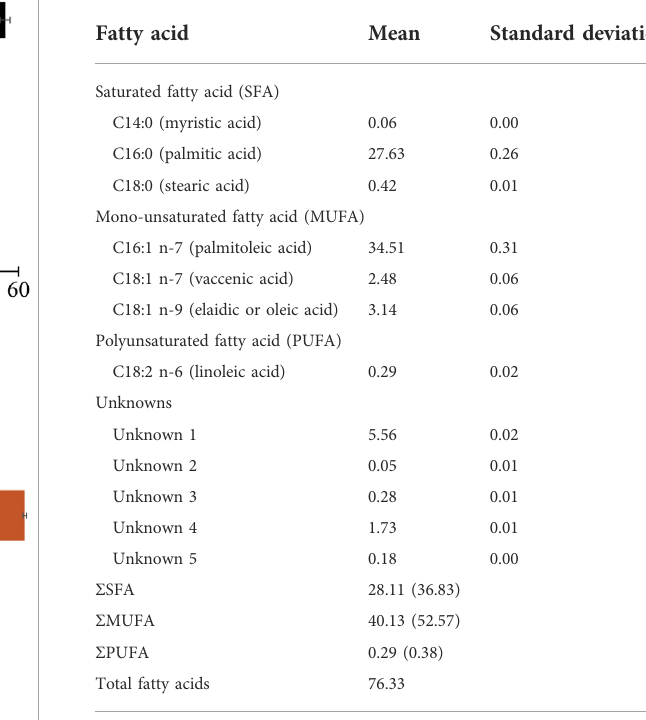
TABLE 2 Fatty acid composition of the unaxenic cyanobacterium Synechococcus sp. UCP002 isolated from the Peruvian Amazon Basin region (mg.g − 1 of